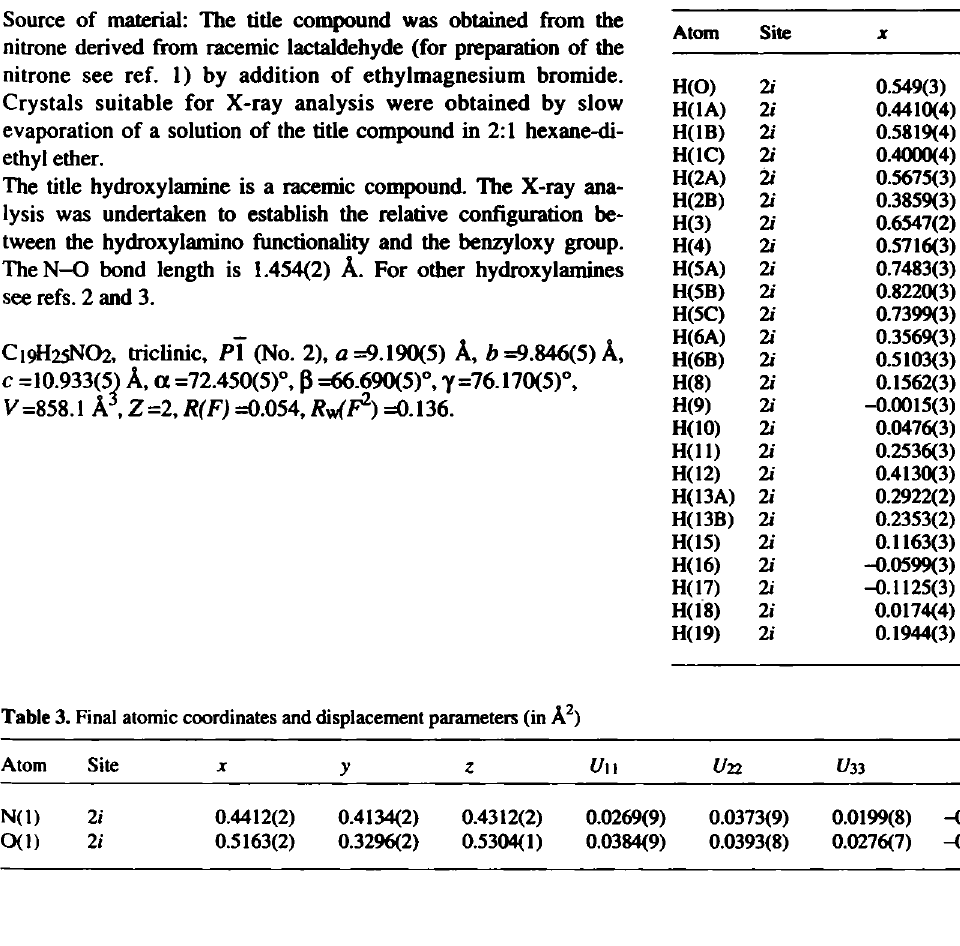
Table 2. Final atomic coordinates and displacement parameters (in Â 2 )